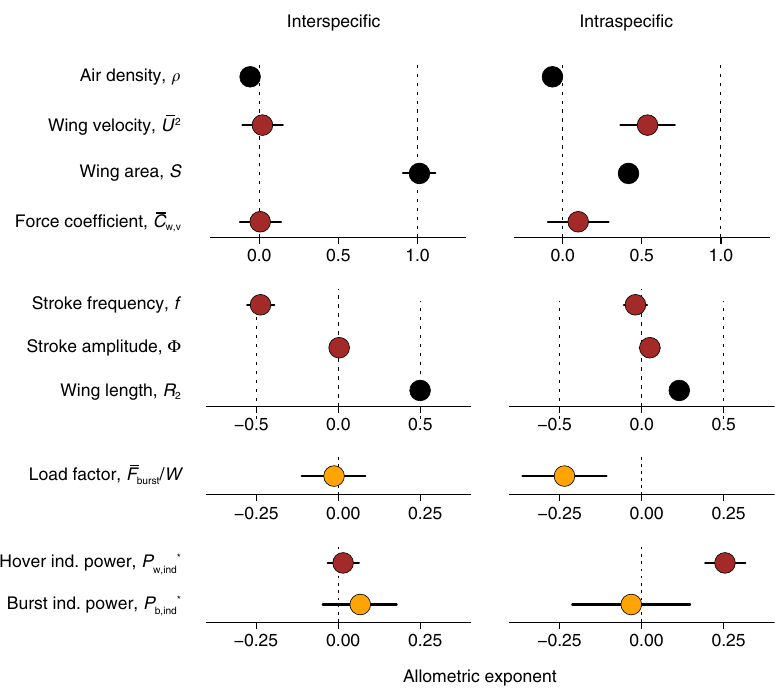
Fig. 4 Comparison of allometric variation among and within species. Constant allometry of wing velocity among species coincides with constant burst force generation (load factor) and induced power. Positive allometry of wing velocity within species coincides with reduced load factor and escalating power requirements. The mean and 95% equal-tailed credible intervals of the posterior distribution of the allometric exponents are shown for each variable. Black circles are static morphological and environmental measurements, red circles were measured during hovering, and gold circles were measured during burst performance. Sample sizes are provided in Supplementary Table